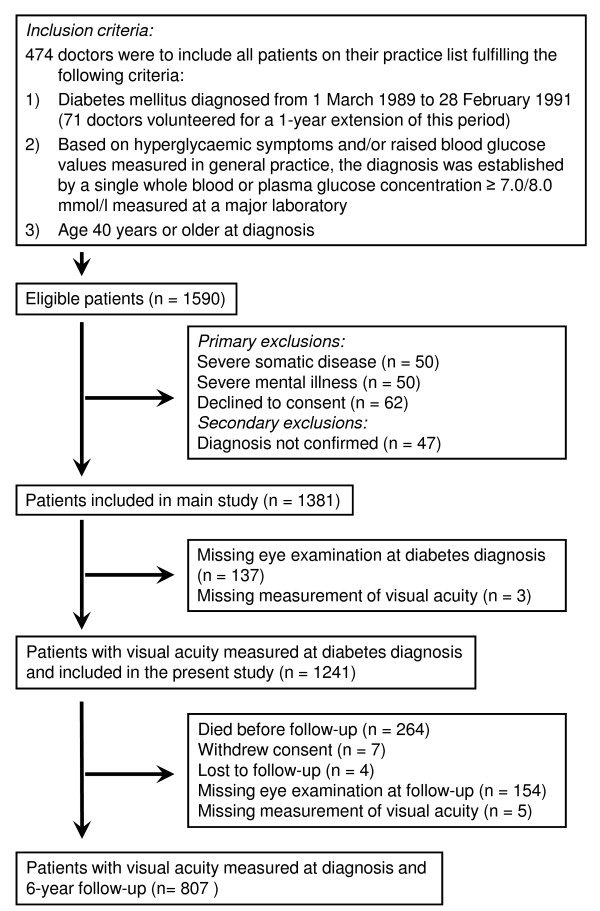
Flow of participants through study.